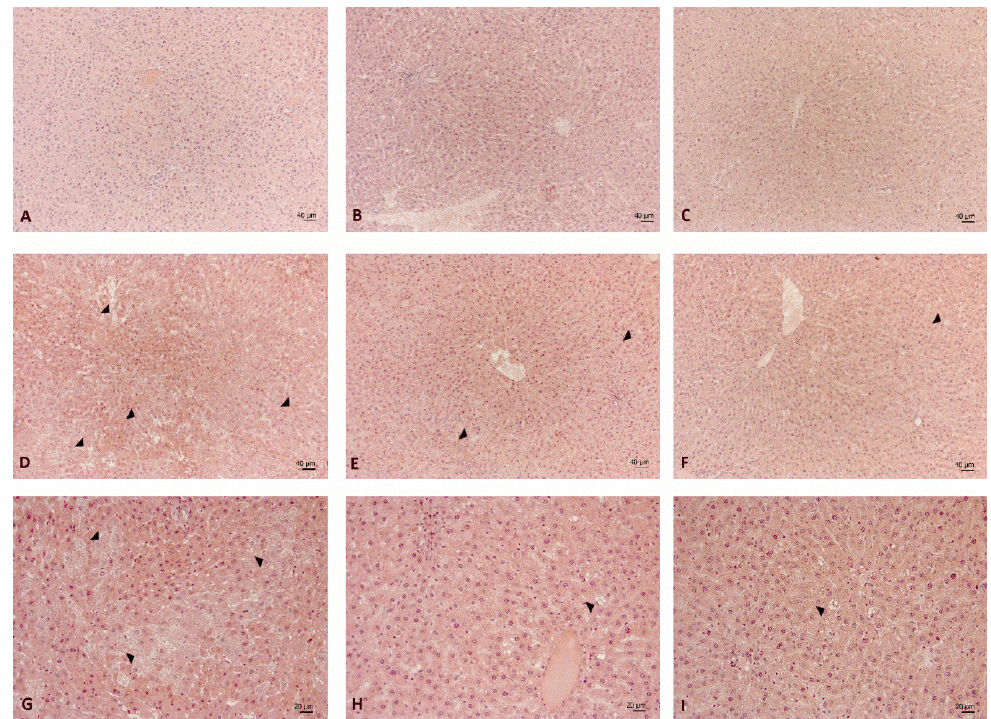
Figure 5. Liver morphology. Representative sections of liver processed for haematoxylin and eosin staining of ( A ) CHOW, ( B ) CS, ( C ) CJS, ( D , G ) DIO, ( E , H ) DS, and ( F , I ) DJS rats. ( A – F ). Magnification 10 × . Calibration bar: 40 µ m. ( G – I ) Magnification 20 × . Calibration bar: 20 µ m. Arrow heads indicate features of steatosis, di ff erently occurring in the experimental groups examined. CHOW—control rats with standard diet; CS—CHOW plus tart cherry seeds; CJS—CHOW plus tart cherry seeds and juice; DIO—diet-induced obese rats; DS—DIO plus tart cherry seeds; DJS—DIO plus tart cherry